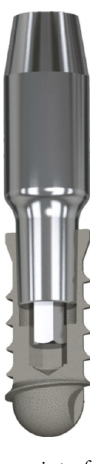
Figure 2: The implants used in this study featured a cone Morse taper interference-fit (TIF) locking-taper, with a taper angle of 1.5 ∘ , combined with an internal